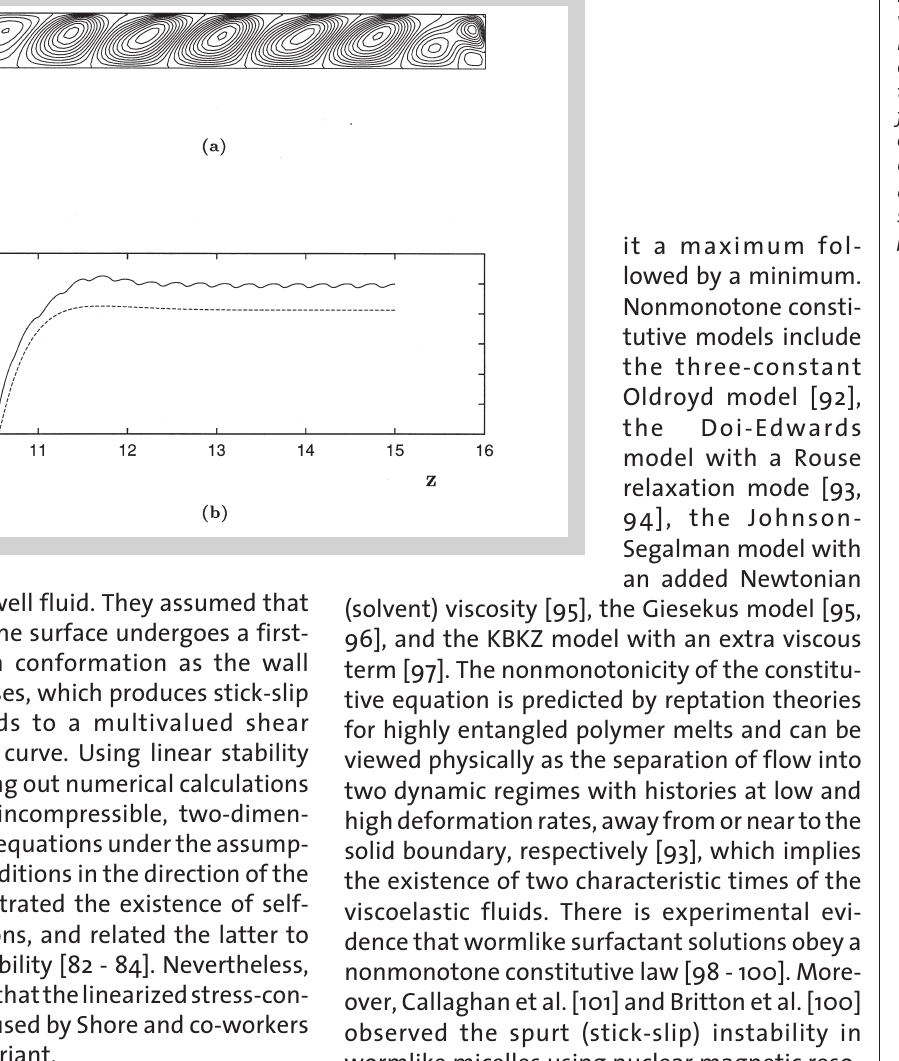
Figure 6: (a) Cells of radial velocity contours in Poiseuille flow of an Oldroyd-B fluid with slip at the wall; (b) Detail of the free-surface oscillations in extrudate-swell flow for Q = 0.45, Re = 1, We = 1, and h 2 = 0.1 (the broken line corre- sponds to the steady-state position of the free